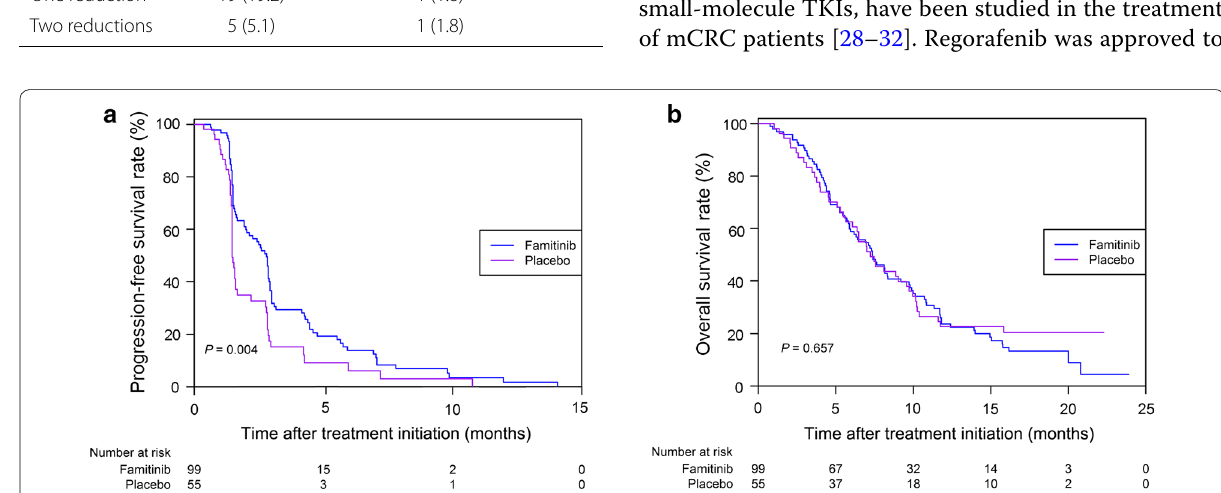
Fig. 2 Kaplan–Meier estimates of progression‑free survival (PFS) and overall survival (OS) probability of mCRC patients treated with famitinib and placebo. a the median PFS in the famitinib group was significantly longer than that in the placebo group ( P